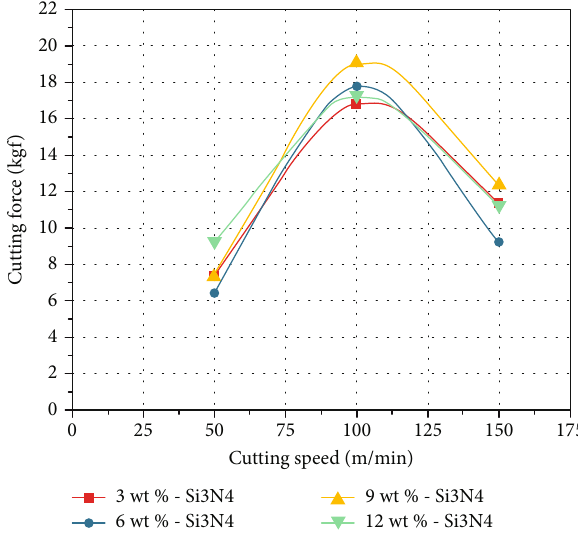
Figure 10: Cutting speed vs. cutting force (depth of cut1.0 mm).